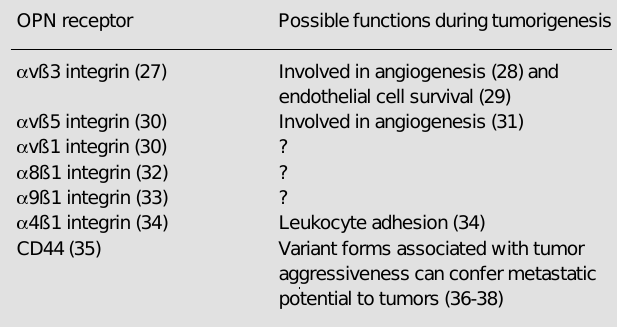
Table 1 - Osteopontin (OPN)